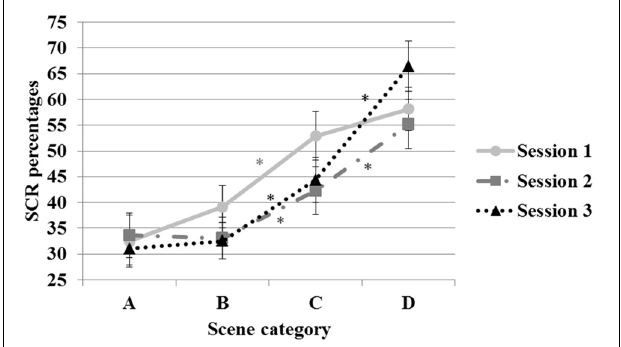
FIGURE 4 | Percentages of SCRs shown by participants in each scene category, depending on the degree of risk developed. Error bars represent standard errors. Asterisks indicate the significant differences as attested by the post hoc